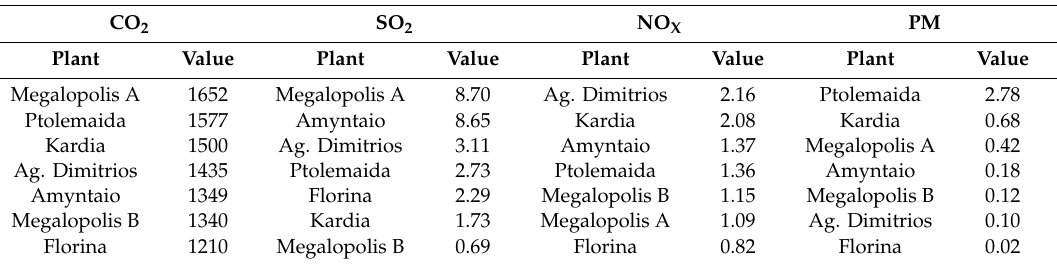
Table A1. Lignite-based thermal power stations in Greece sorted by their emission factors (data as acquired from [53]).